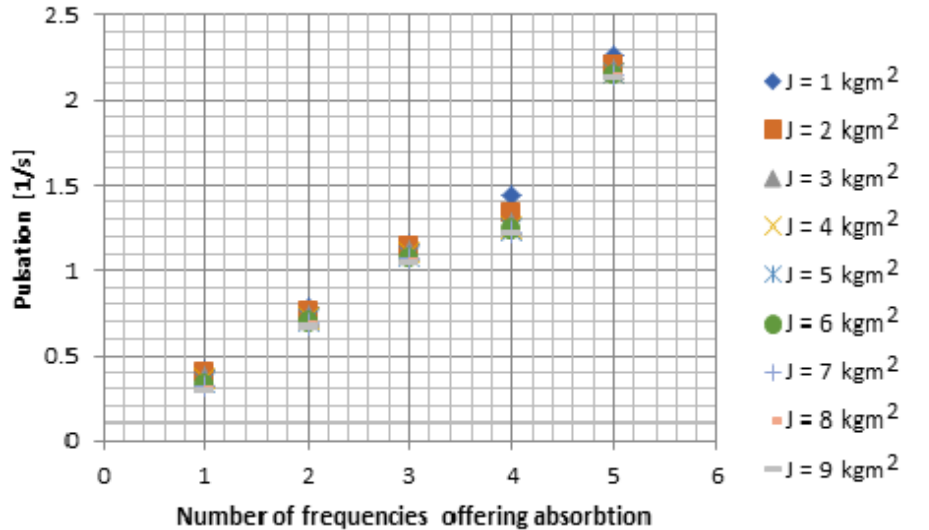
Figure 10. The intervals of pulsations that ensure the rest of the flywheel 6 for different moment of inertia of the flywheel 2.